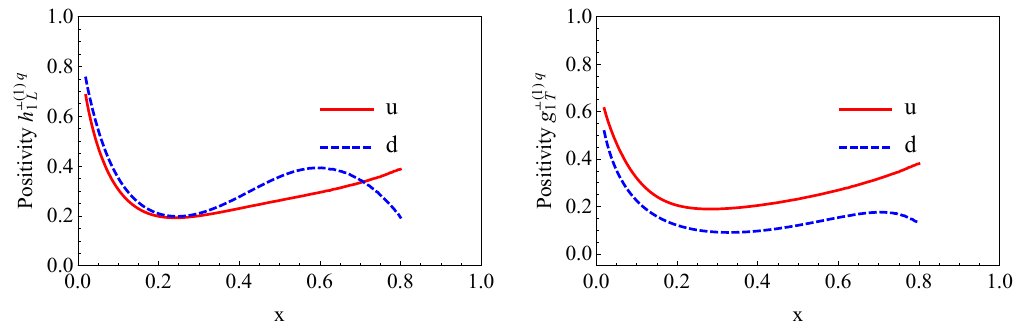
Figure 13. The normalized inequalities for g ? (1) q ( x ) and h ? (1) q ( x ) vs. x which are obtained by 1 T 1 L integrating (6.3a) and (6.3b) over k ? and normalizing with respect to the sum of the absolute values of the individual terms. The result must be positive and smaller than unity if the WW-type approximations and the application of the Gaussian model are compatible with positivity, see